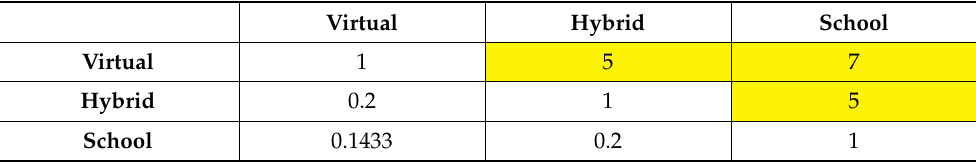
Table 4. Pairwise Comparison and Weights for the 3 Alternatives under the Safety